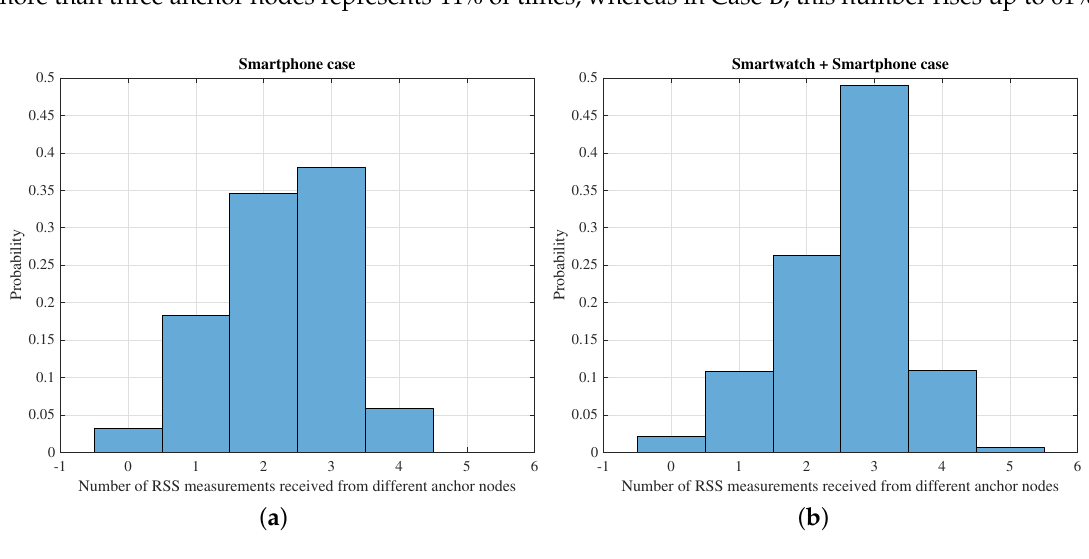
Figure 4. Normalized histograms of the number of RSS measurements received from different anchor nodes at each time instant: ( a ) case of only using the smartphone for the measurements ( b ) case of using the smartphone and the